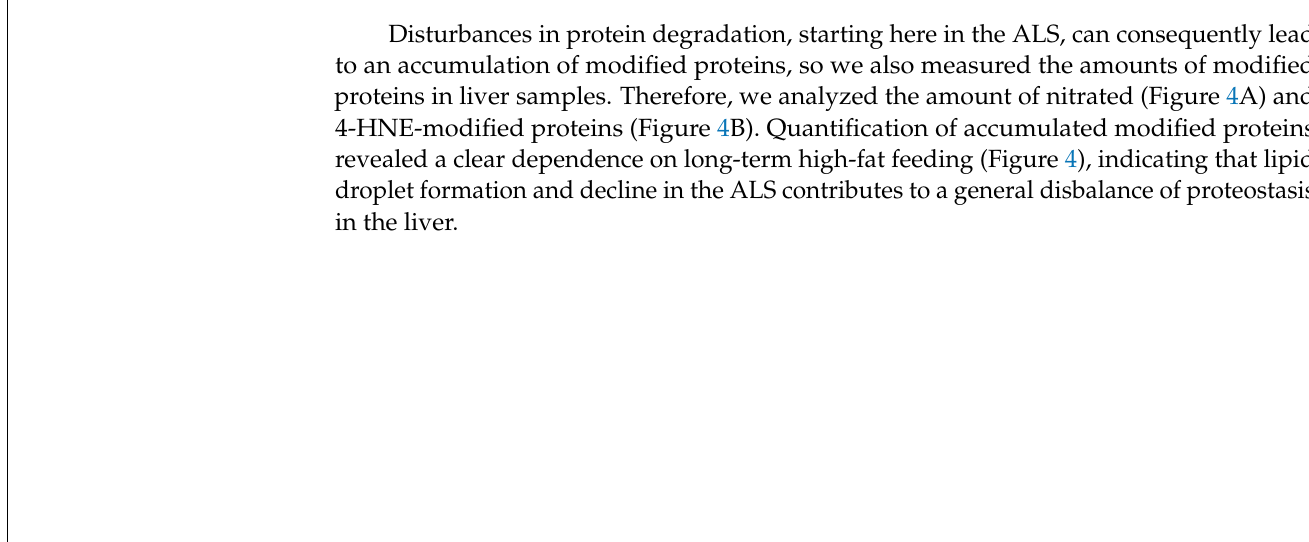
Figure 3. Protein degradation systems in liver of high-fat diet exposed mice. Lysosomal (panel A ) and 20S proteasomal (panel C ) activities were determined as described in the Methods section. Panel B shows the amount of the LAMP-1 protein together with a representative blot and the corresponding ponceau staining. Data in Panel A and B were normalized towards 22w SD B6 (set as ‘1’). Statistical analysis was performed by one sample t -test (indicated by #) or unpaired t -test (indicated by *), directly comparing two selected samples. Statistical significance means: a—versus 22w; b—vs. 39w B6 and c—vs. 22w NZO SD. The data presented are the mean ± standard deviation, n =